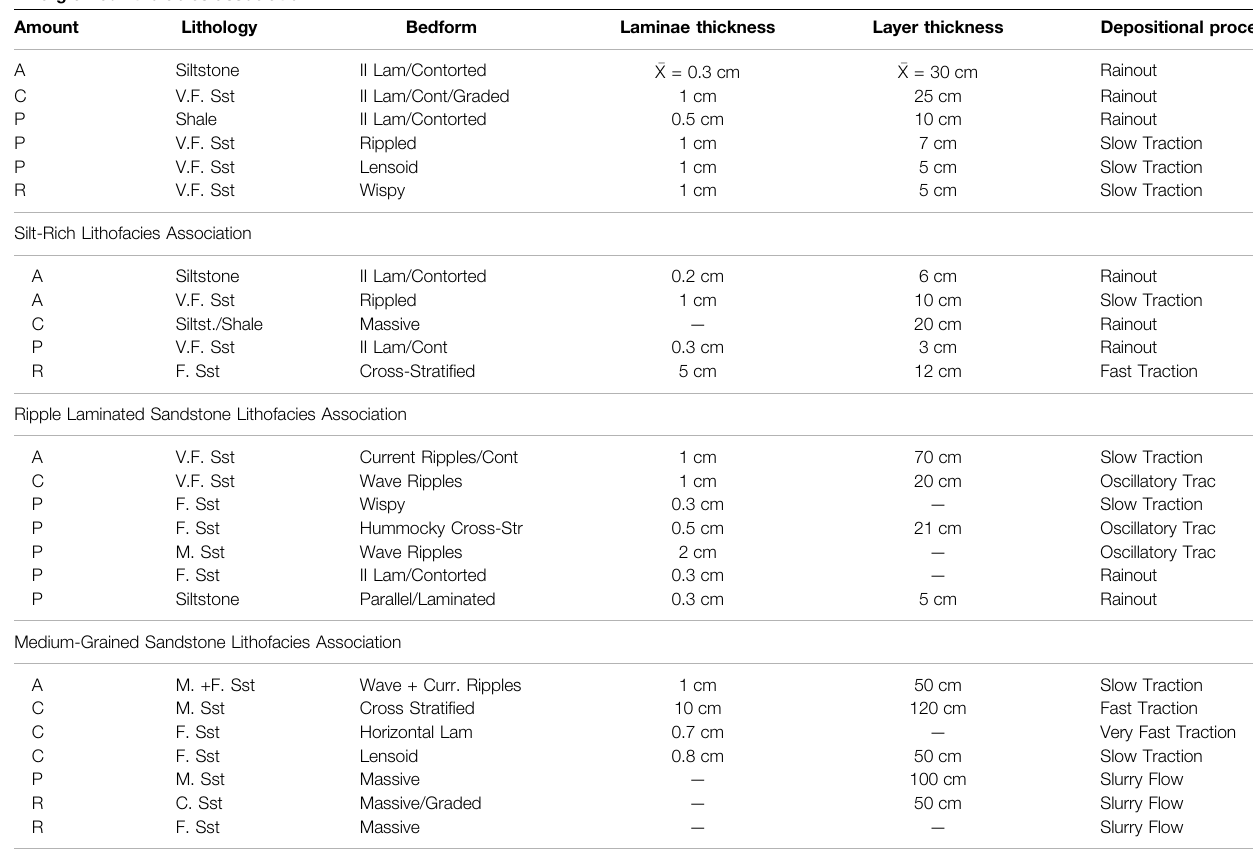
TABLE 1 | Lower coarsening upward